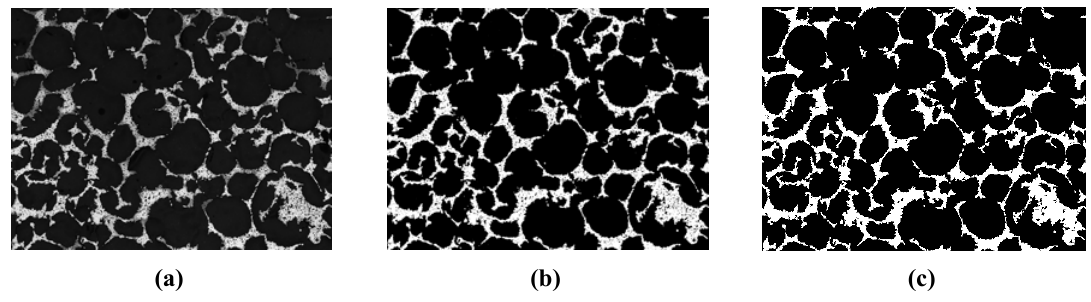
Figure 1. Three steps of image pre-processing for the line segmenting method on MF-50. ( a ) Light microscope image; ( b ) Binarized image; ( c ) Structures < 10 pixels deleted.